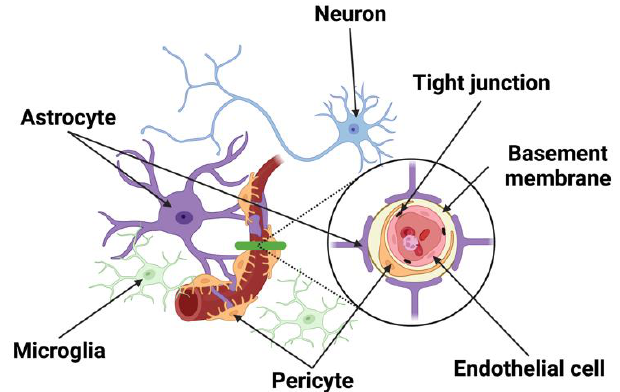
Figure 1. Schematic of the NVU. The NVU is comprised of neurons, vascular cells (endothelial cells, pericytes), basement membrane, and glia (astrocytes, microglia). Neurons make distinct connections with blood vessel and other cells of the NVU. Endothelial cells forming the blood vessels are encased by a basal lamina/basement membrane and are bound by tight junction proteins. Located in the brain parenchyma, astrocytes make contact with both pericytes and endothelial cells at the capillary wall, while pericytes are situated between the end feet of astrocytes and endothelial cells.